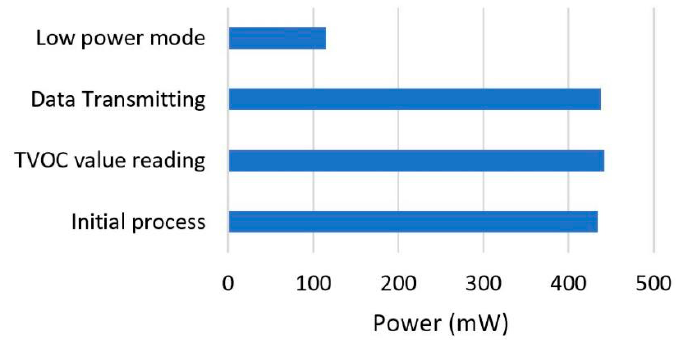
Figure 10. Power measurement